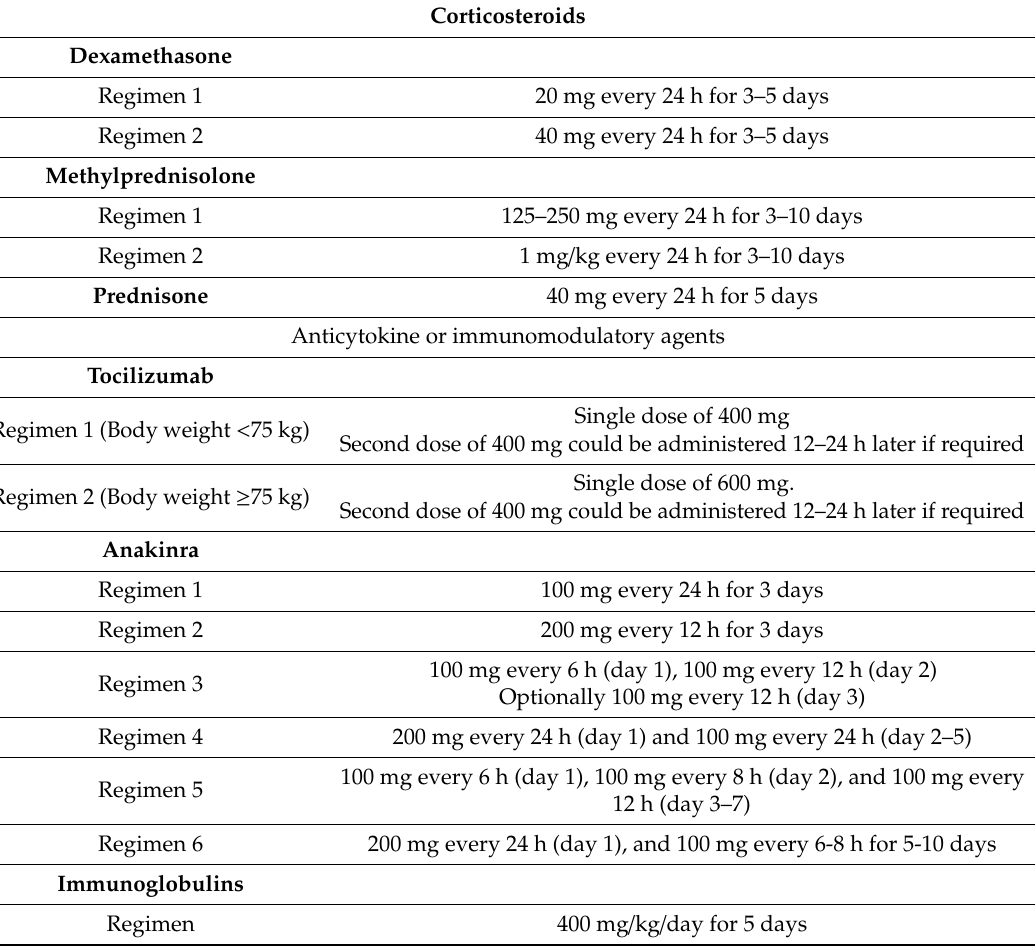
Table 3. Dosage and duration of treatment of corticosteroids, anticytokine or immunomodulatory agents, and immunoglobulin therapy for coronavirus disease